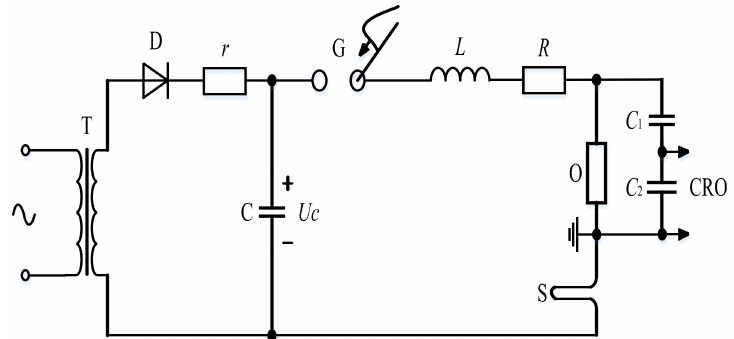
Figure 6. Electromagnetic transient impact test circuit of fuse. C : main capacitor; S: shunt; CRO: oscilloscope; G: spark sphere gap; R , L : resistance and inductance of all components and loops of the line; D: silicon stack; r : protection resistor; T: charging transformer; O: sample.